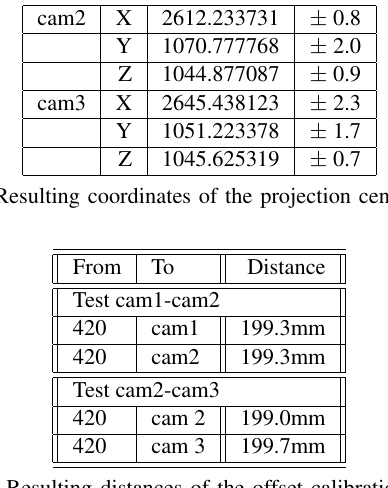
Merging geospatial-